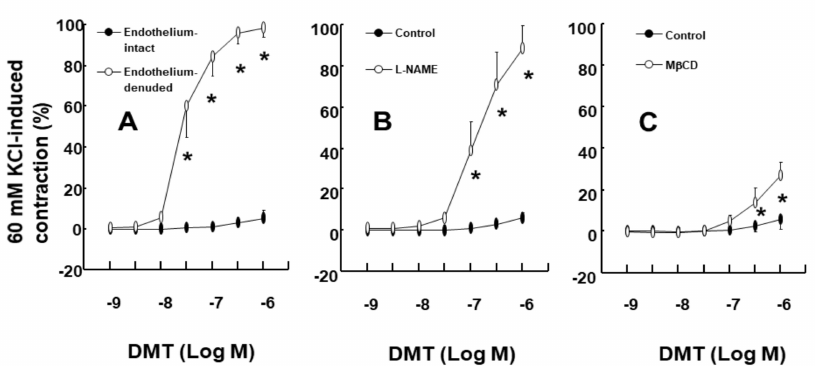
(Figure 3A), whereas high concentration (3%) of LE inhibited the DMT-induced contraction (Figure 3A; p < 0.05 vs. control at 10 − 7 M to 10 − 6 M DMT). Furthermore, high concentration (3%) of LE inhibited the DMT (10 − 6 M)-induced maximal contraction in the endothelium- denuded aorta (Figure 3B; p < 0.001 vs. control in 10–60 min). Alpha-2 adrenoceptor inhibitor rauwolscine (3 × 10 − 6 M) inhibited DMT (10 − 6 M)-induced contraction in the endothelium-denuded aorta (Figure 3C; p < 0.001 vs. control in 10–60 min).